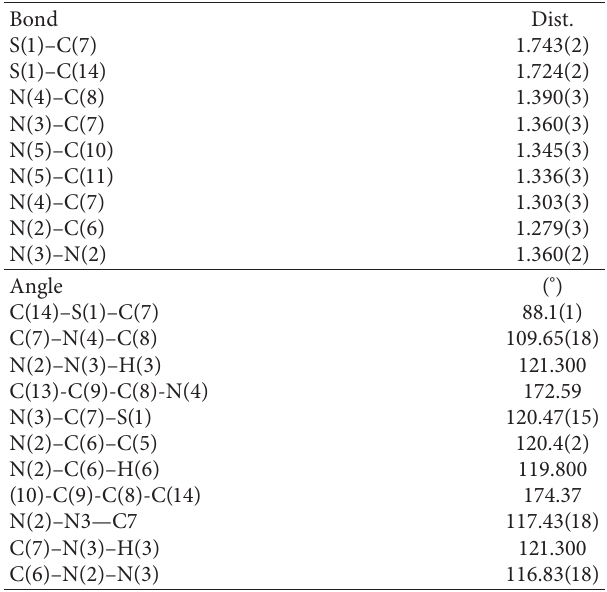
Table 3: Selected bond lengths (˚A) and bond angles ( ° ) of L2. Bond